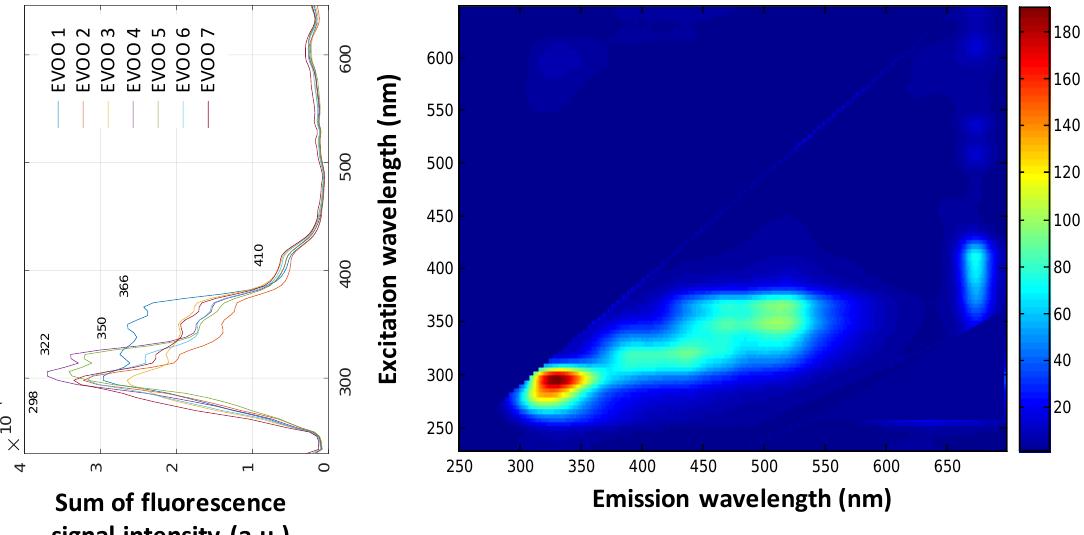
Figure 2. Three-dimensional front-face fluorescence spectroscopy. Left : Excitation spectra of seven extra virgin olive oil (EVOO) samples (wavelengths at local maxima are indicated). Right : example of three-dimensional front-face fluorescence spectra obtained from EVOO l sample. Excitation spectra are obtained as the sum of the emission intensity signals along the x axis from 250 to 698.5 nm.